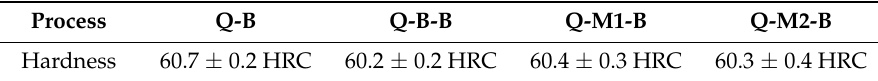
Table 2. Hardness result for the specimens treated by different processes.